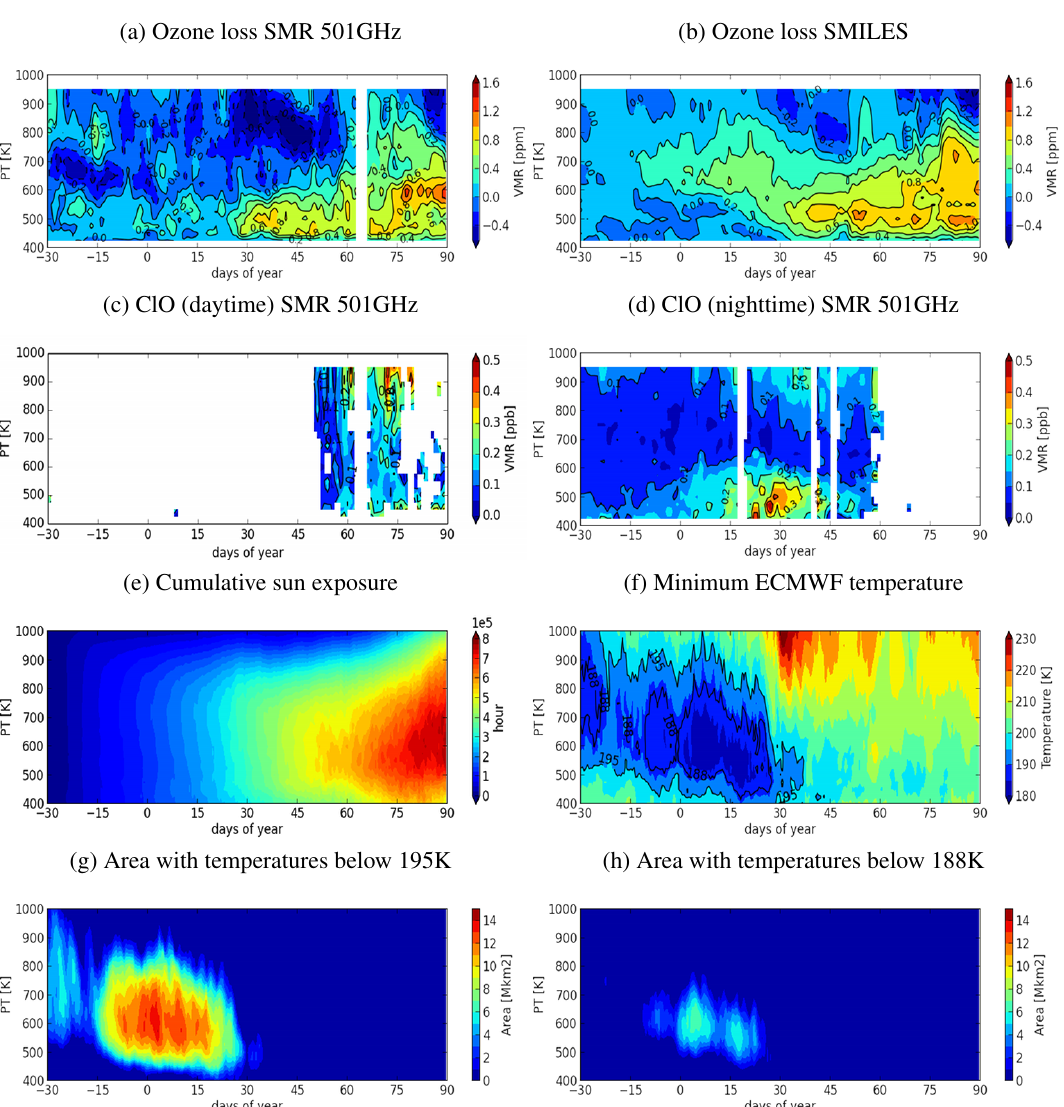
Figure 10. Vortex averages of several parameters in the area where equivalent latitudes are larger than 70 ◦ as a function of time (days from 1 January 2010) and isentropic levels between 400K and 1000K. (a, b) Vortex mean ozone loss derived from SMR and SMILES, respectively. (c, d) Vortex mean ClO retrieved from SMR in daytime and nighttime, respectively. (e) Cumulative solar exposure time of the polar vortex. (f) Minimum air temperature inside the vortex derived from ECMWF. (g, h) Areas where the temperature is below T NAT and T ice , respectively.